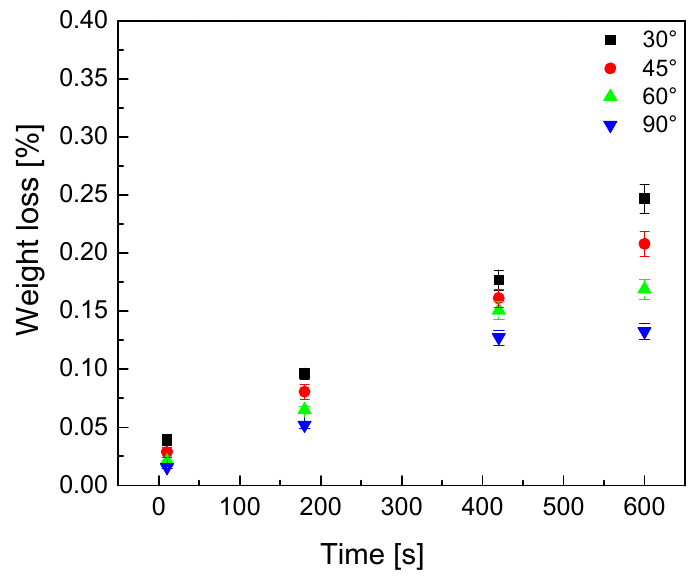
Figure 4. Weight loss of API X120 steel specimen with time. Each data point indicates average of 3 tests at each condition. Error bars indicates 1 sigma scatter.